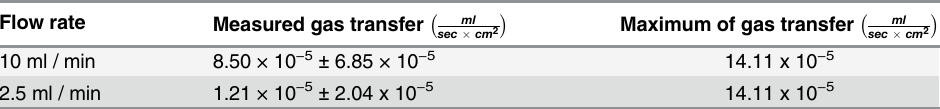
Table 4. Gas transfer of uncoated Lumox ™ slide.